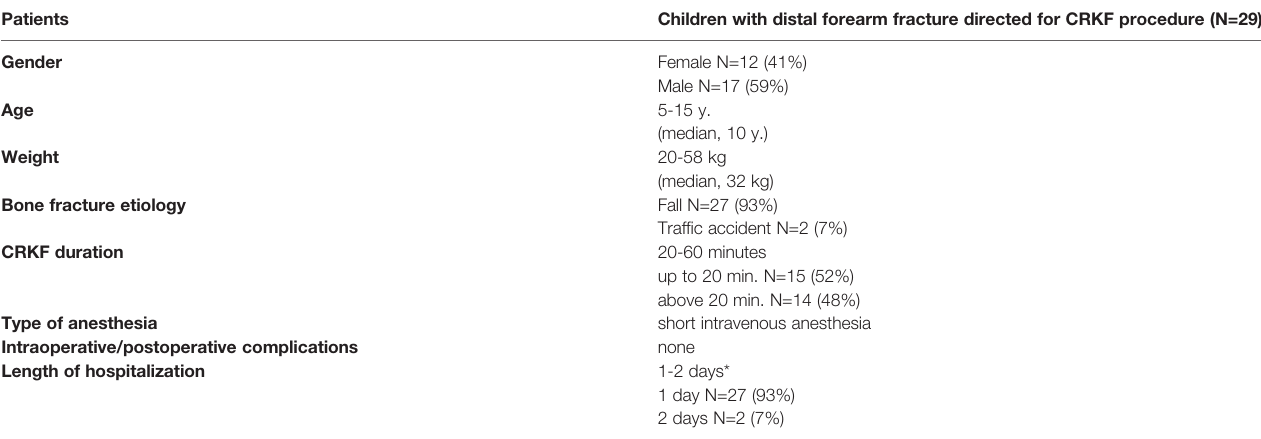
TABLE 1 | Demographical data and clinical characteristics of children with distal forearm fracture. Patients Children with distal forearm fracture directed for CRKF procedure